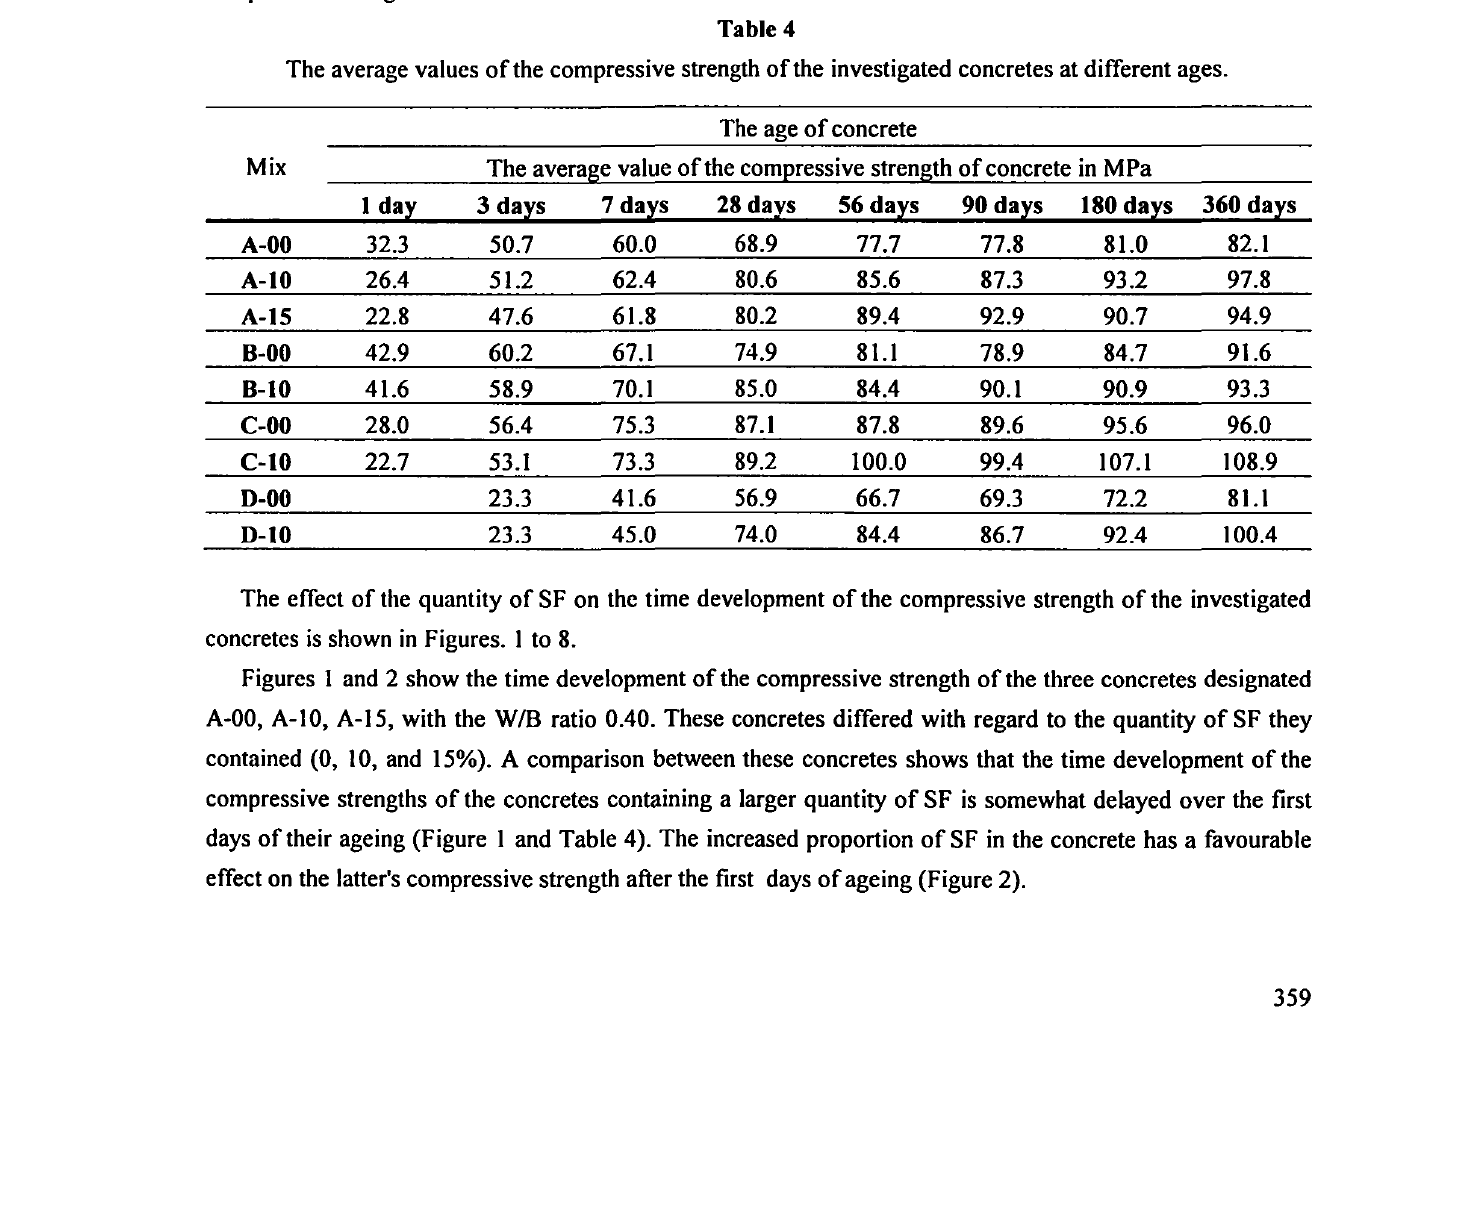
The average values of the compressive strength of the investigated concretes at different ages. The age of